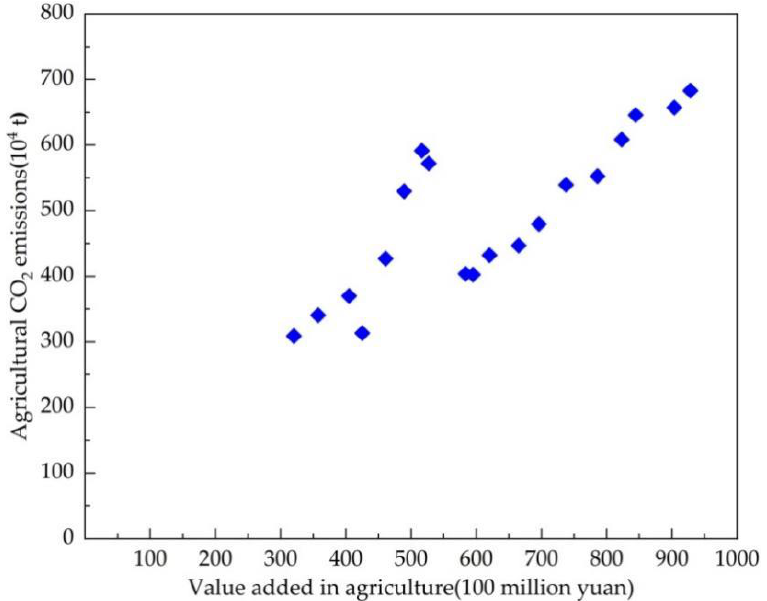
Figure 2. Scatter plot of agricultural CO 2 emissions and value added in agriculture in Jilin province during 2000–2018.